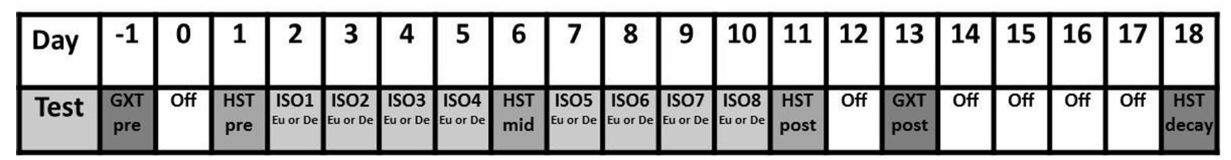
FIGURE 1 | Experimental protocol for examining the effect of hydration on the adaptive responses to exercise in the heat. GXT, Graded Exercise Test; HST, Heat Stress Test; ISO, Isothermal strain acclimation session; Eu, Euhydration; De,